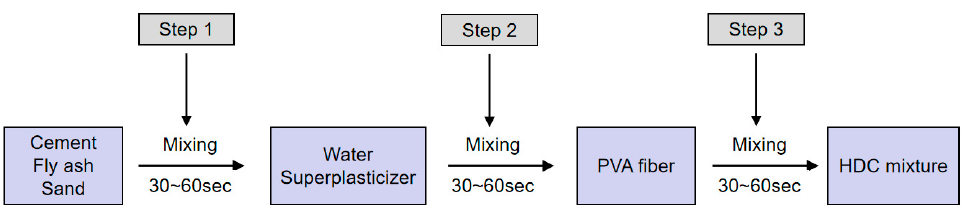
Figure 2. HDC mixing process Figure 2. HDC m ixing process flowchart.